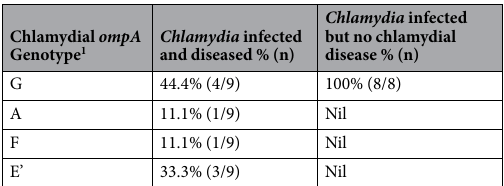
Table 4. The prevalence (percentage) of Chlamydia pecorum ompA genotypes identified in free-ranging koalas ( Phascolarctos cinereus ) inhabiting a population in south-east Queensland, Australia. Koalas are grouped via: Chlamydia infected and diseased, n = 9 versus koalas that are infected but with no clinical disease, n =